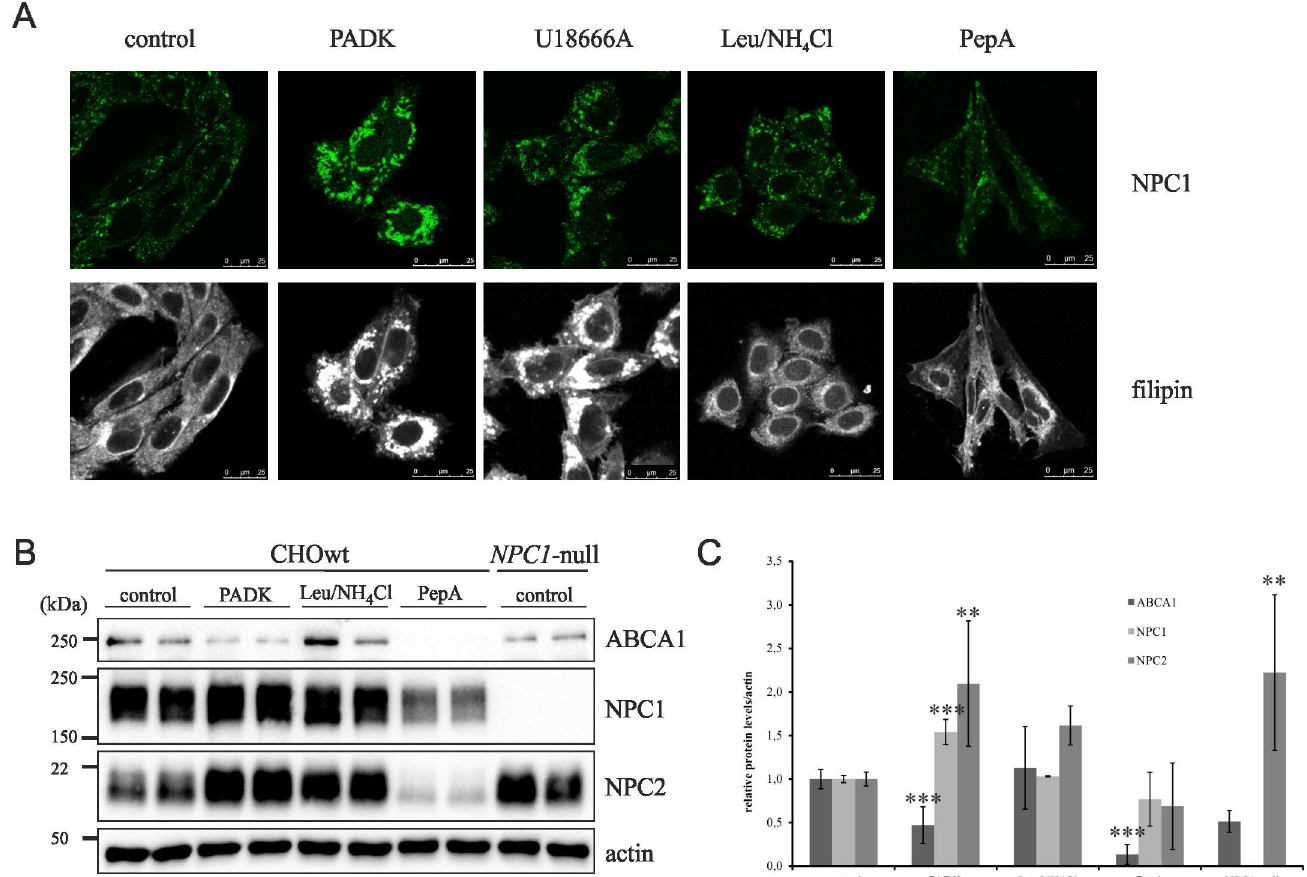
Fig 2. Cathepsin B/L inhibition causesNPC disease-like cholesterol accumulation in CHO cells. (A) Confocalmicroscopy of CHOwt cells treated with different inhibitors.Cholesterol (filipin staining, white) and NPC1 (green). (B) Western blot of CHOwt cells treated with different inhibitors using ABCA1, NPC1 and NPC2 antibody. β -Actin was used as a loadingcontrol. (C) Quantification of Western blot results of the 3 independent experiments was performed by ImageJ. Student t-test was used for statistical analysis. Error bars present the mean ± standarddeviation( ** p < 0.01, *** p <